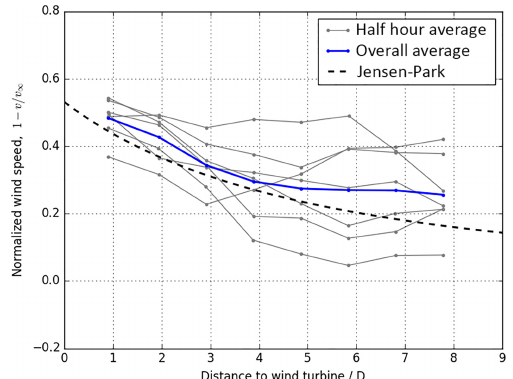
Figure 13. Wind speed deficit behind the wind turbine when us- ing minimal wind speeds of line-of-sight measurements of the three lidars for wind speed